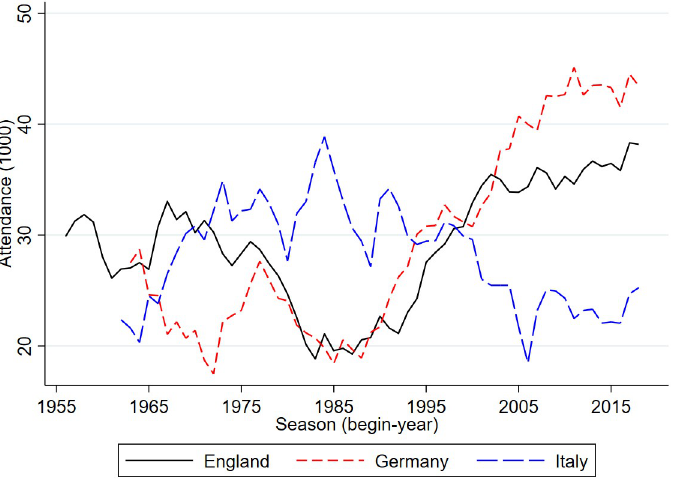
Fig 1. Stadium attendance professional football; England, Germany, Italy; 1956/57-2018/19 (1000).